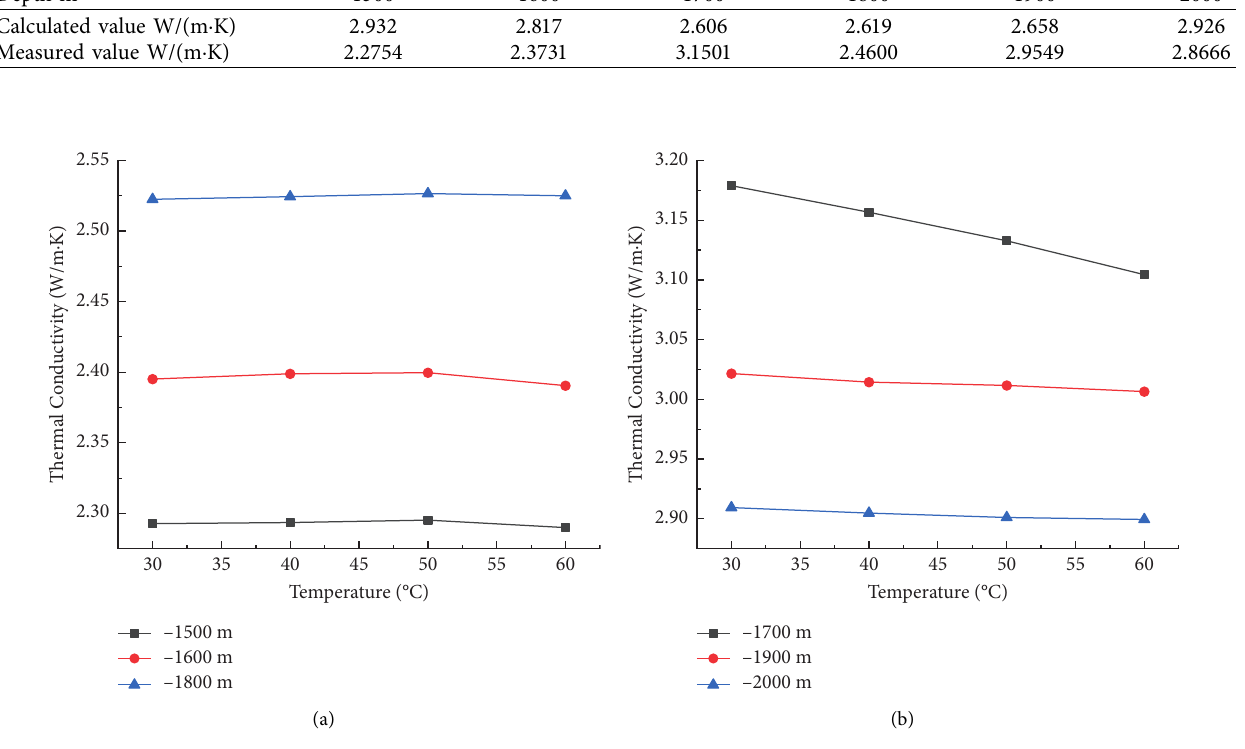
Figure 3: Variation of thermal conductivity with temperature for rock samples from 1,500 to 2,000 m depth in the Xiling construction project area of Sanshandao gold